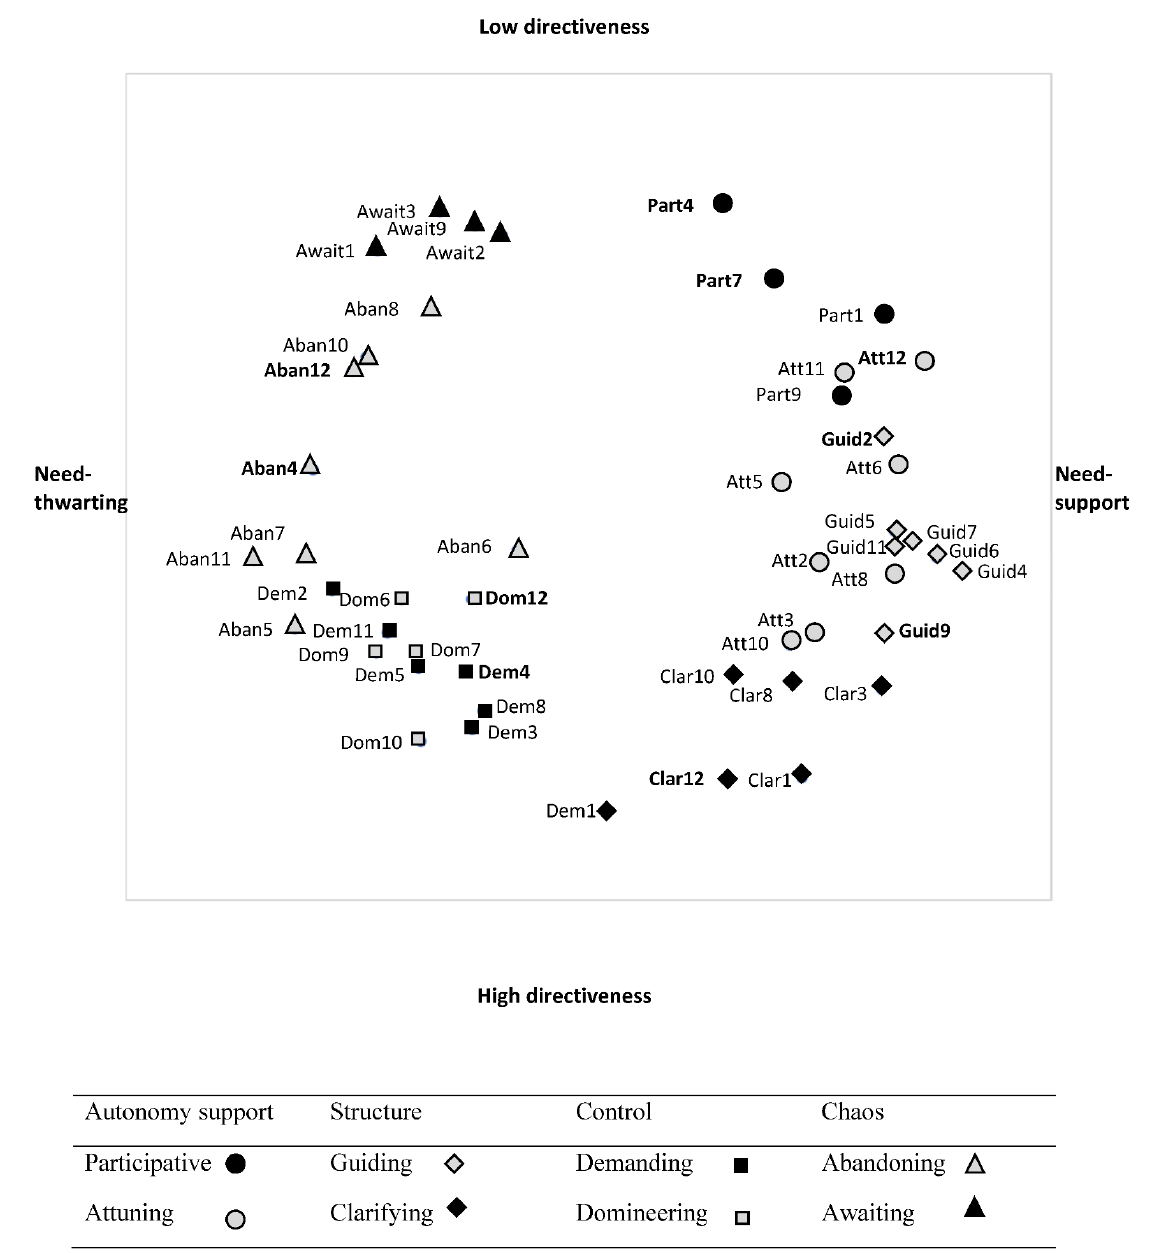
Figure 4. Two-dimensional representation of the SIS-PE items in France. Relying on the definitions of the scales in the original SIS-Education (Table 2), we then checked the structure of the subareas performing a series of CFAs on the items of two adjacent approaches. Precisely, we compared a two factor versus a single-factor solution (see [12] for similar analyses). Except for two pairs of adjacent areas (demand- ing/domineering and participative/attuning) in the French sample ( ∆ χ 2 = 1.89 and ∆ χ 2 = 0.04, respectively), and one pair (participative/attuning) in the total sample ( ∆ χ 2 = 1.63), results of χ 2 change tests showed that a two-factor solution was more suitable than one factor solution. The fits improved for each test from a one-factor to a two-factor solution (6.41 < ∆ χ 2 < 131.68, p = 0.05). Moreover, reliability analyses showed that, except for the participative subarea ( ω = 0.45 in the total sample; ω = 0.44 in Belgian sample and ω = 0.41 in French sample), internal consistencies for the all the subareas were acceptable to good, varying between 0.69 and 0.82 (see Tables